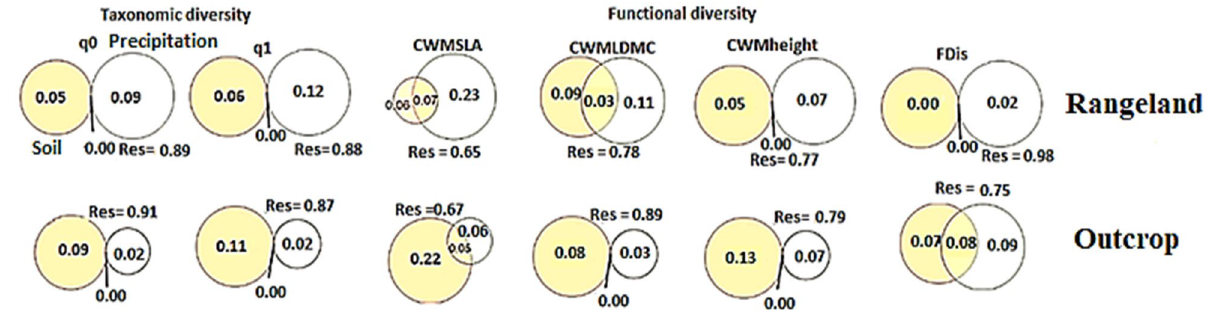
Figure 3. The relative contribution of environment (in yellow; i.e. soil factors; organic carbon (OC) for rocky outcrops, Phosphorus (P) for surrounding rangelands) and precipitation (in white) to taxonomic (q0 and q1 indices) and functional (CWMALA, CWMLDMC, CWMheight and FDis) in surrounding rangelands (up) and rocky outcrops (down). Values represent the adjusted R 2 ‐